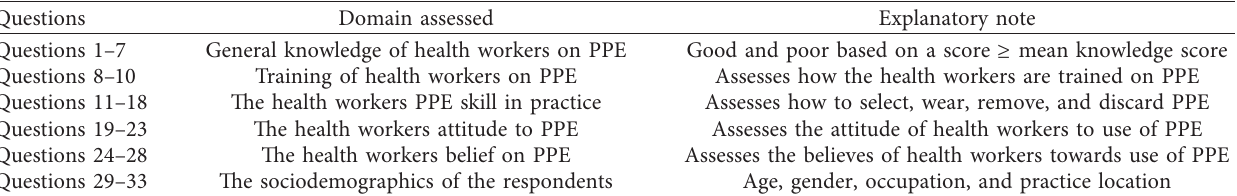
Table 1: Summary of the semistructured questionnaire.